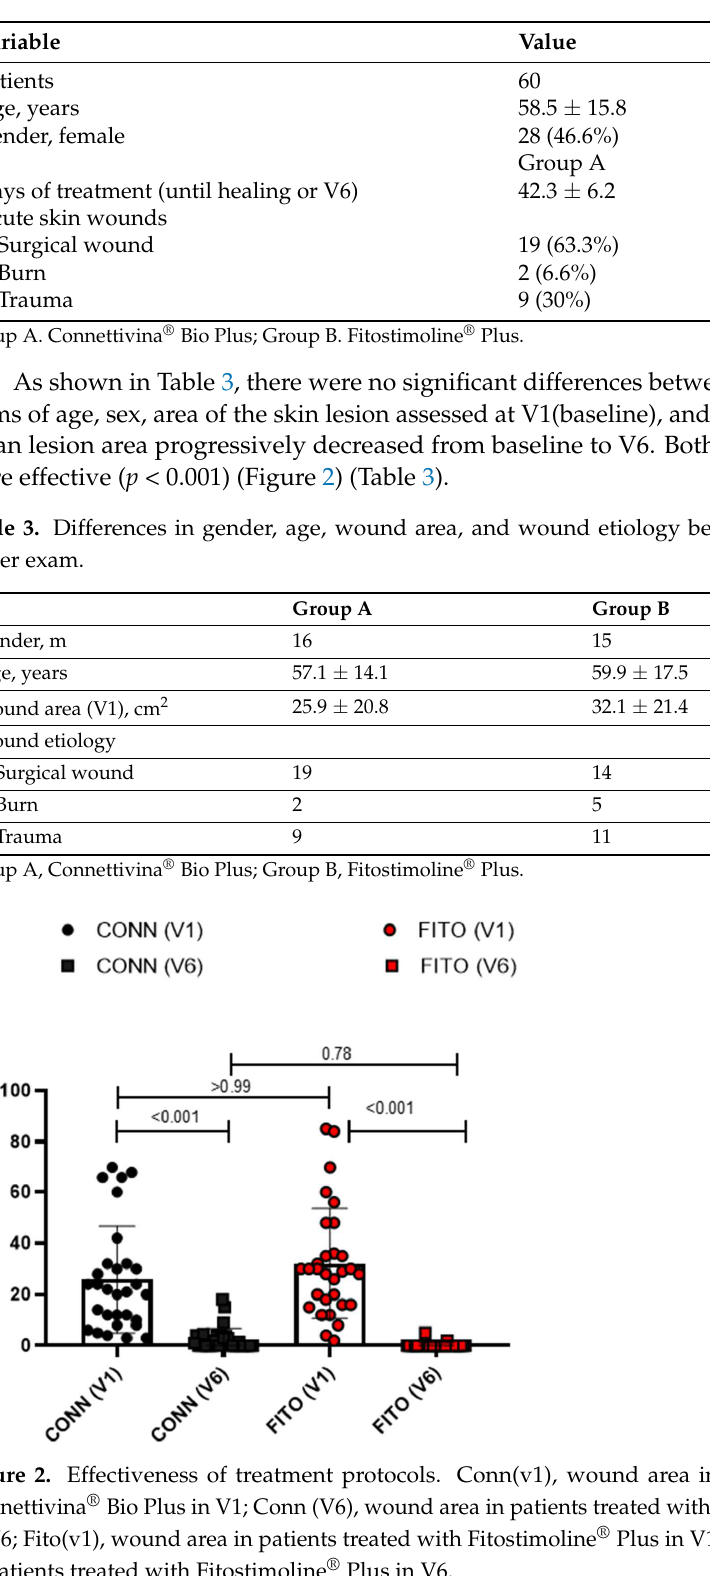
Table 2. Patients and treatments.